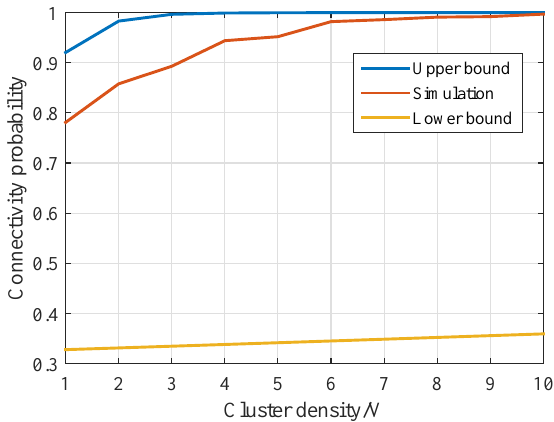
Figure 9. The theoretical bounds of the j th cluster with SNR th = 20